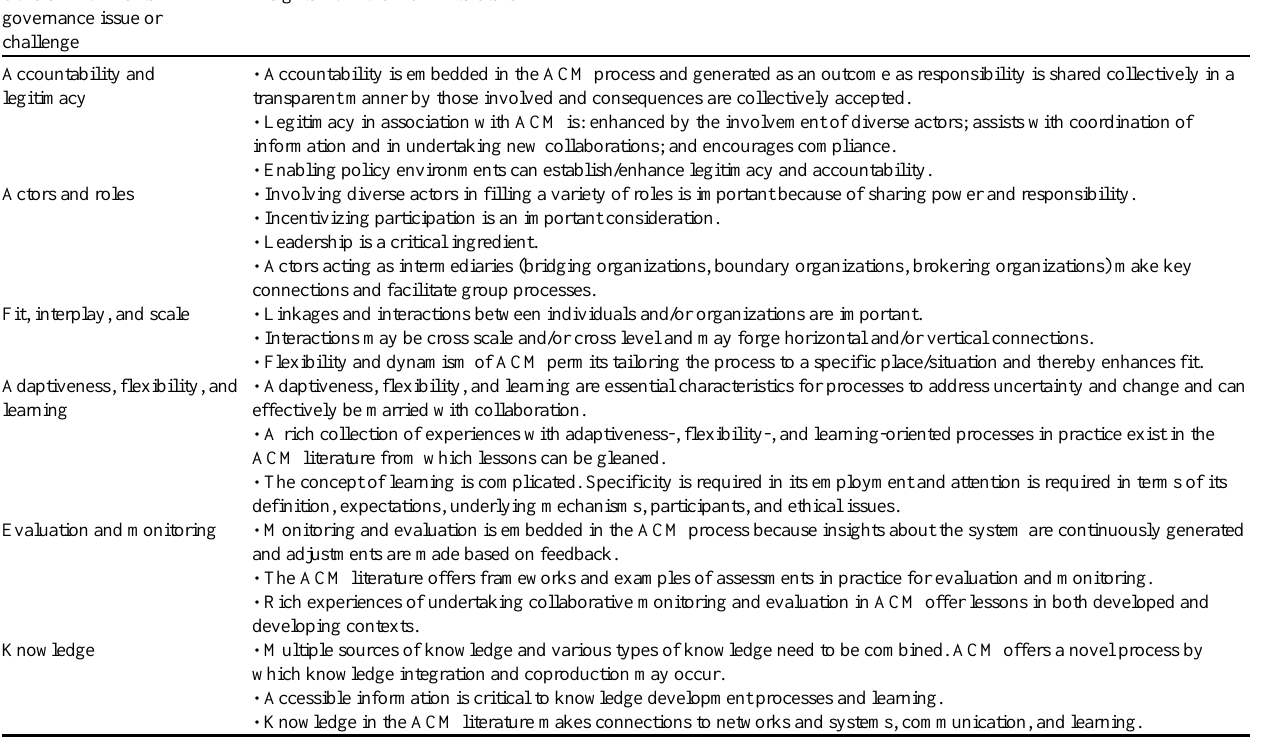
Table 3 . Key insights from the ACM literature contributing to understanding/addressing core environmental governance issues or